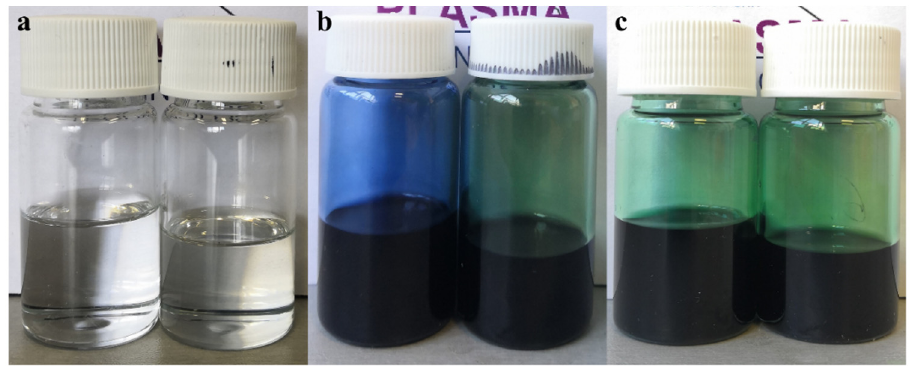
Figure 3. Photographs of the polymer solutions pre ‐ and post ‐ plasma treatment: ( a ) PLA (left) and PLA ‐ APPJ (right), ( b ) PLA/PAni (left) and PLA/PAni ‐ APPJ (right) and ( c ) PLA/PAni:CSA (left) and PLA/PAni:CSA ‐ APPJ (right).